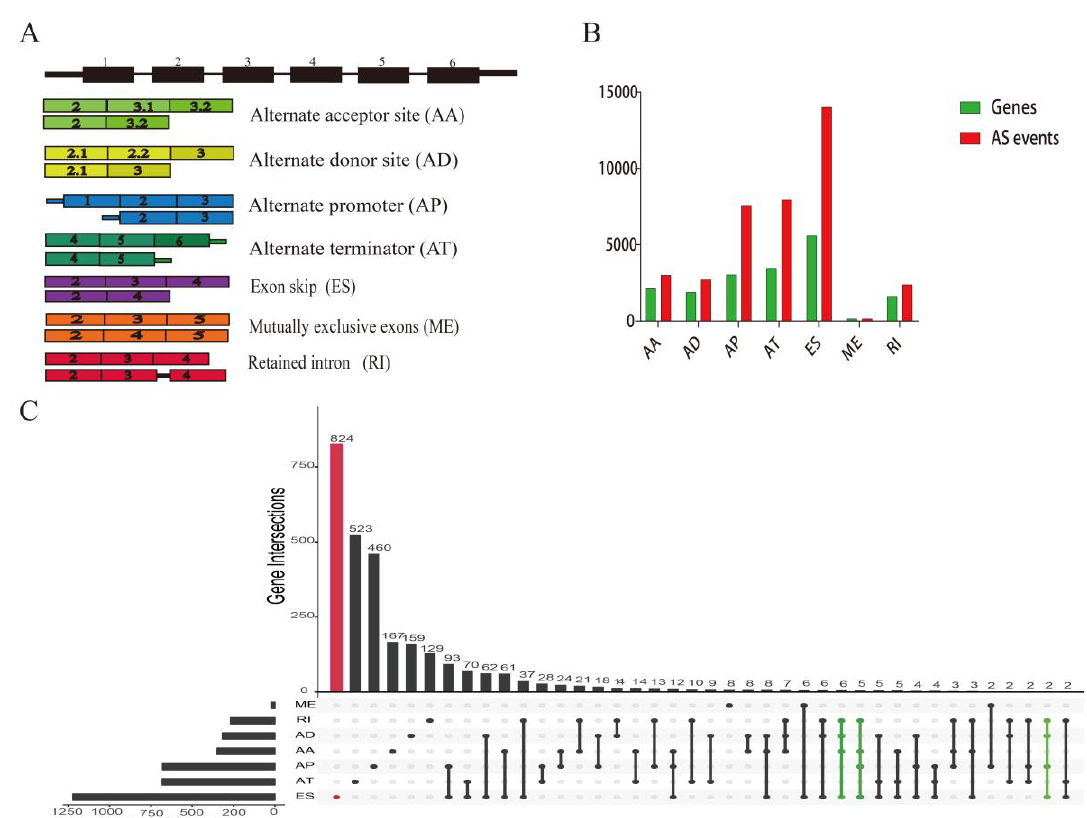
Figure 1. Landscape of alternative splicing (AS) events in uveal melanoma (UM). AA, alternate acceptor; AD, alternate donor; AP, alternate promoter; AT, alternate terminator; ES, exon skip; ME, mutually exclusive exons; RI, retained intron. ( A ) Illustration for seven types of alternative splicing in this study. ( B ) The number of AS events and corresponding genes included in the present study; the x-axis stands for the types of alternative splicing, and y-axis means the number of genes and AS events. ( C ) UpSet plot of different types of alternative splicing types in UM. The dark bar on the left of drawing represents the amount of each type of AS event. The dark dots in the matrix at the right of drawing represent the intersections of AS events. One gene might possess several alternative splicing patterns (dark dot line), and even a single gene can undergo four types of alternative splicing (green dot line). ES was the most common type of the alternative splicing events (red bar).